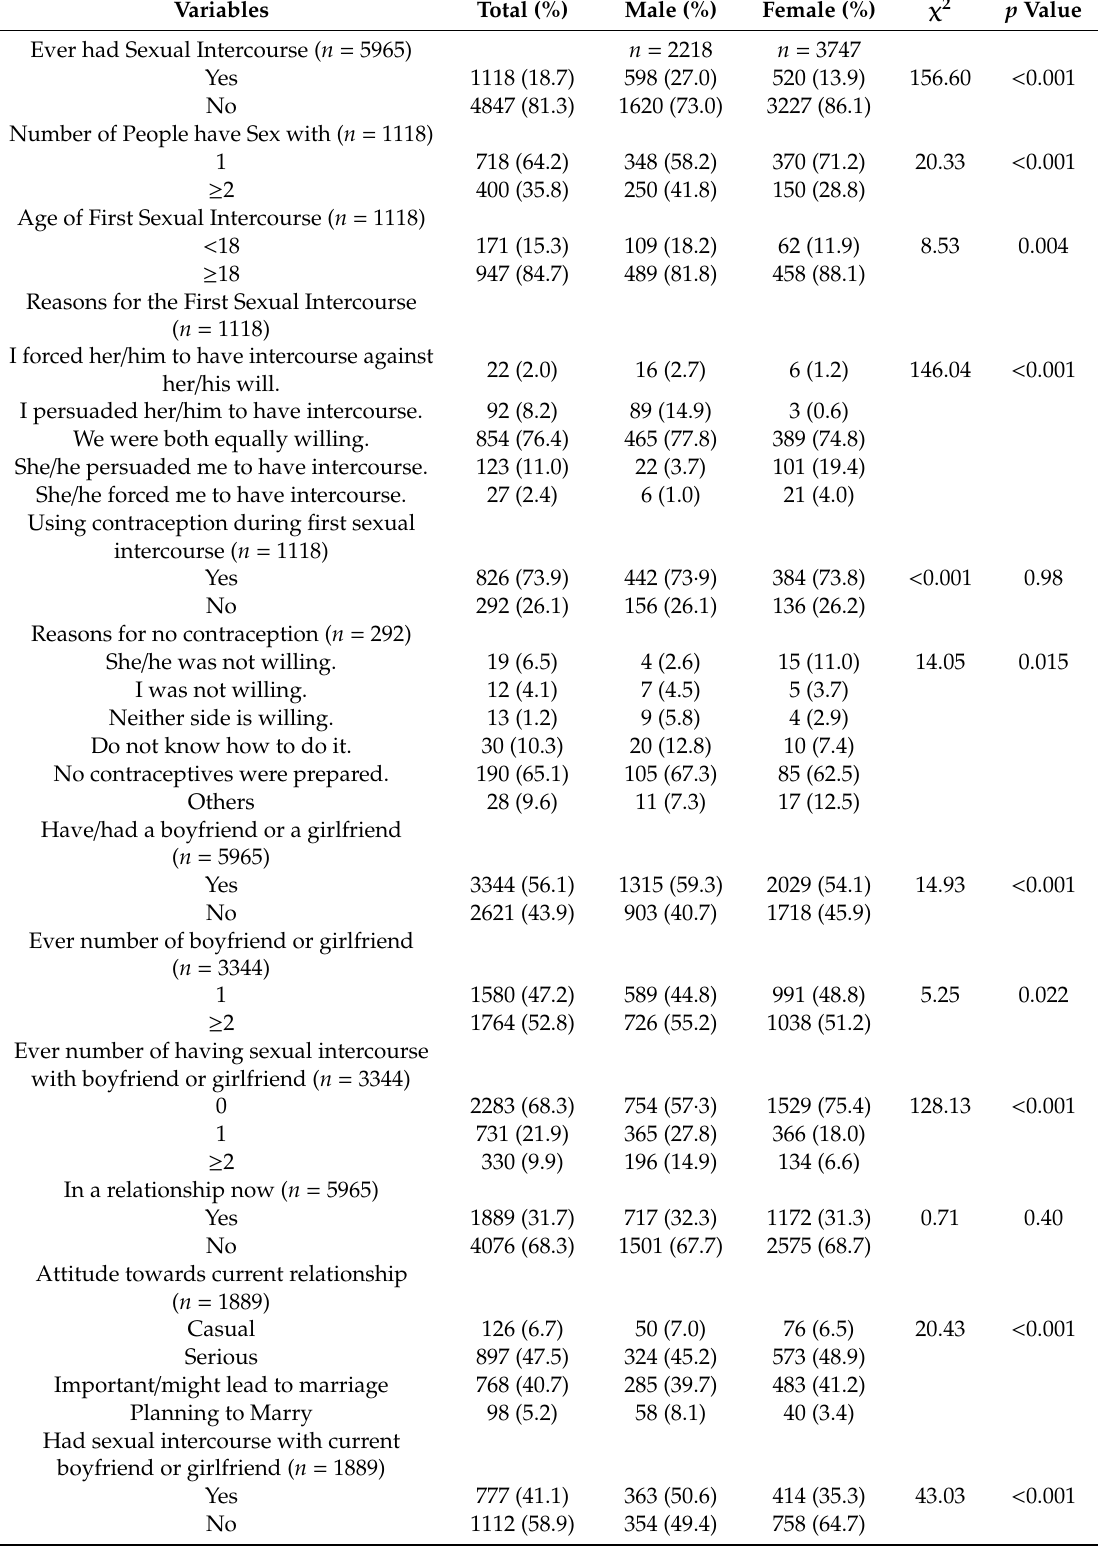
Table 6. Sexual behavior of Chinese university students by